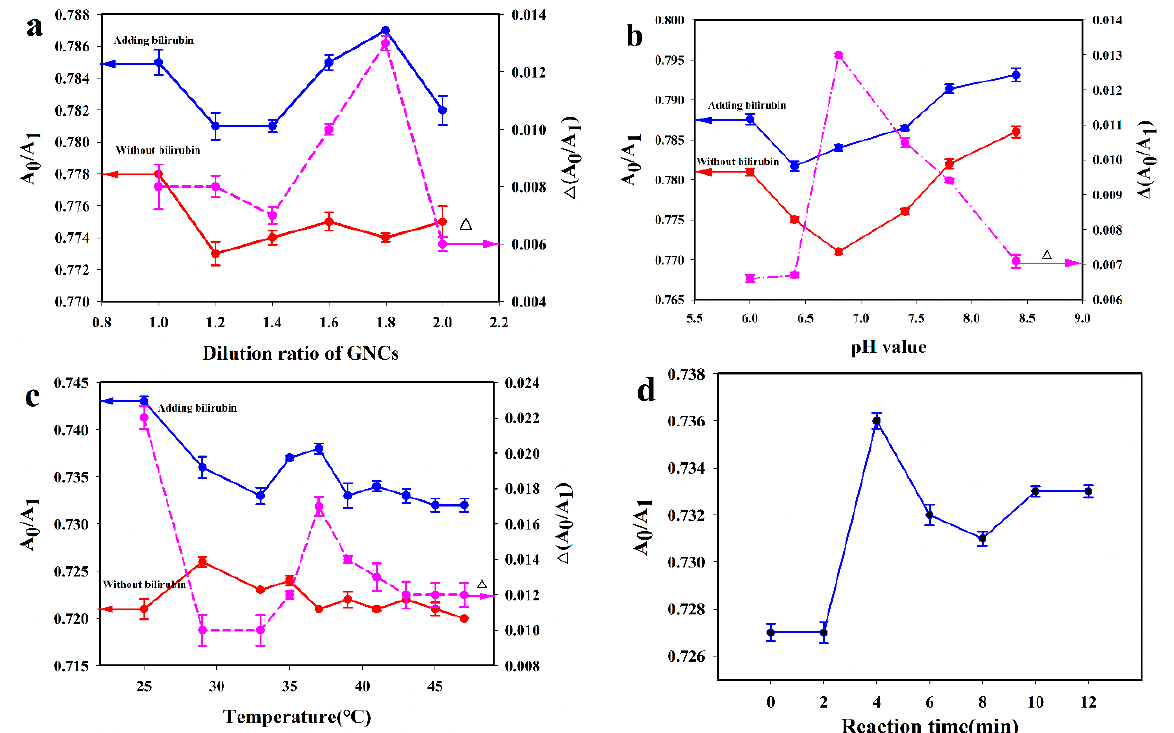
Figure 4. ( a ) Effect of dilution of GNCs, ( b ) temperature, ( c ) media pH and ( d ) reaction equilibrium time on bilirubin catalysis. The final bilirubin concentration was 0.20 μ M.